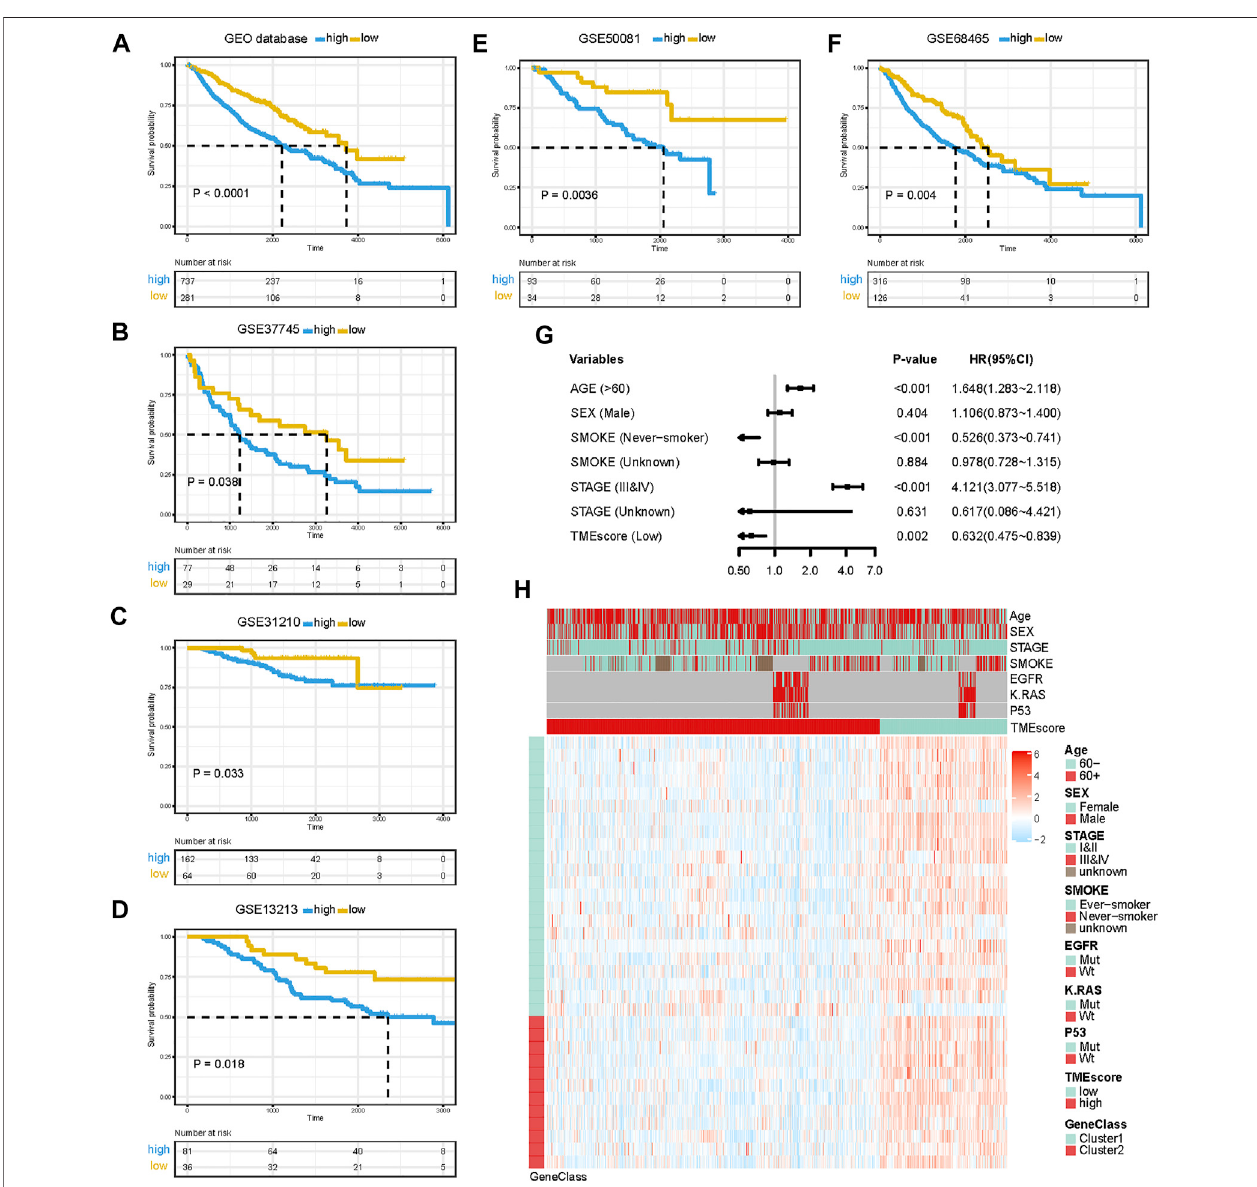
FIGURE 3 | Prognostic value of TMEscore for LUAD patients in fi ve GEO cohorts. (A) K-M curve of all 1,018 patients in the GEO database between different TMEscoregroups(log-ranktest, p < 0.001). (B – F) K-Mcurvesof fi veindependentGEOdatasetsindifferentTMEscoresubgroups. (G) Forestplotsillustratingtheresults ofthemultivariateCoxproportionalhazardsmodelofclinicalfeaturesintheGEOdatabase. (H) Heatmap ofDEGexpression and clinicalcharacteristics. TMEscore,age, sex, stage, smoke, mutation of KARS, mutation of EGFR, and mutation of P53 are shown as patient annotations. Gene clusters are shown as gene annotations. Top legend, gray indicates a missing